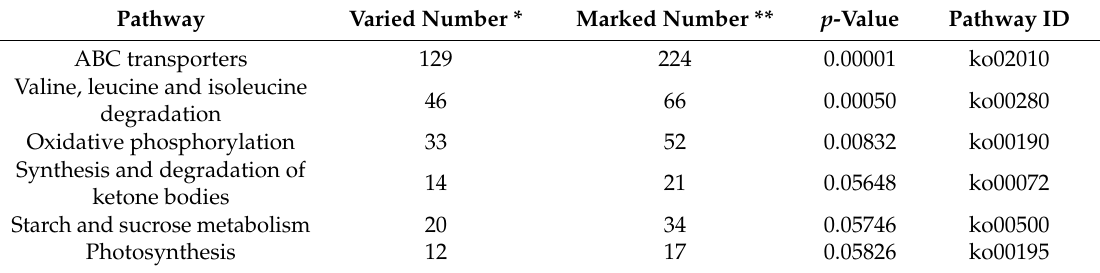
Figure 5. Top pathways enriched in the Kyoto Encyclopedia of Genes and Genomes analysis. A large rich factor indicates a high degree of enrichment. Table 3. Control (MC1-CK) vs. salt-treated (MC1) pathway enrichment.